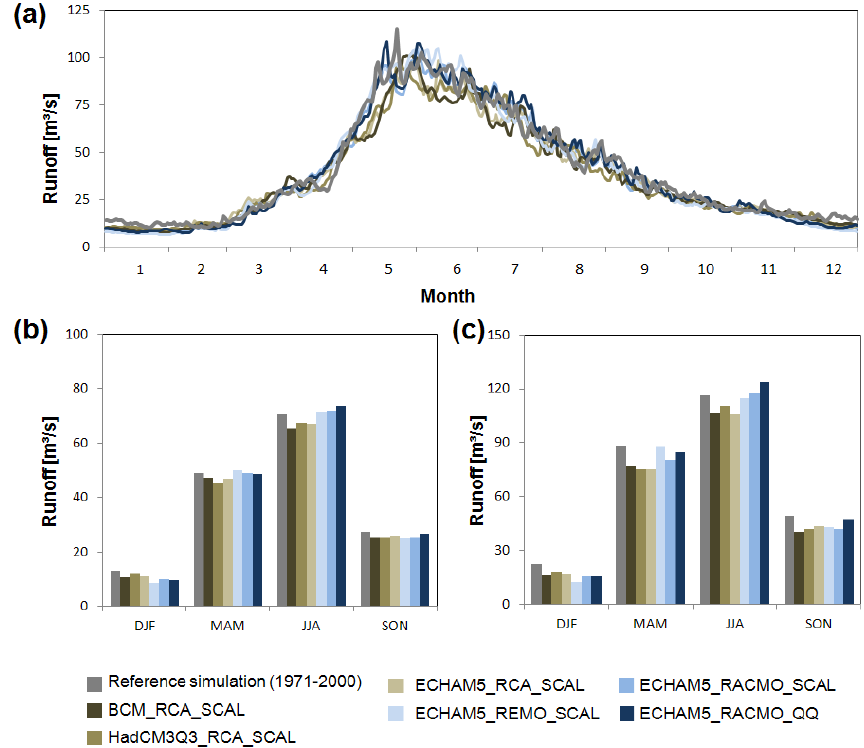
Fig. 5. Runoff from HQsim simulations using observed station data (reference simulation) and the different modelling chains showing (a) mean daily runoff, (b) mean seasonal runoff and (c) the mean seasonal 90%-quantile of daily runoff.